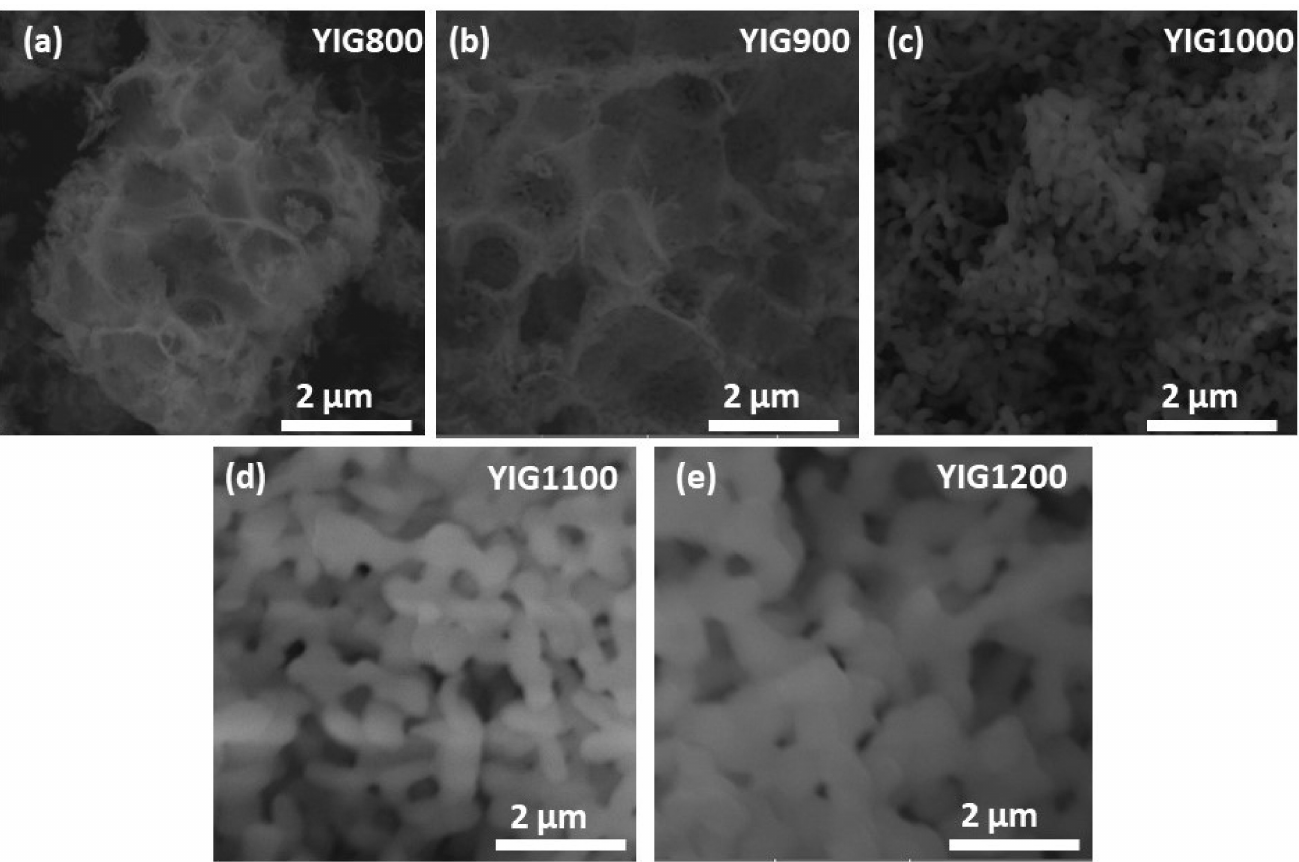
Figure 1. SEM images of YIG particles synthesized at 800 ( a ), 900 ( b ), 1000 ( c ), 1100 ( d ), and 1200 ( e ).